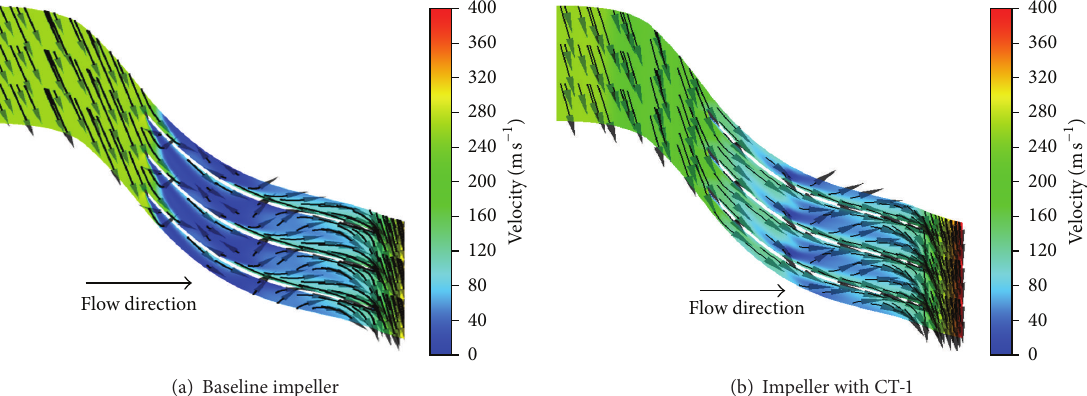
Figure 24: Relative velocity vectors on spanwise planes of baseline and CT-1 impellers near tip at stall mass flow rate of baseline